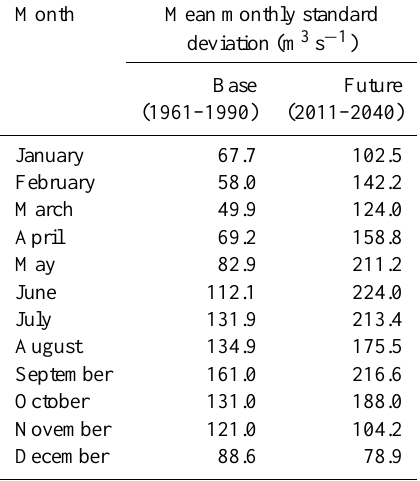
Table 3. Mean of standard deviation of monthly flows during the base and future periods – Santo Ângelo gauge station.